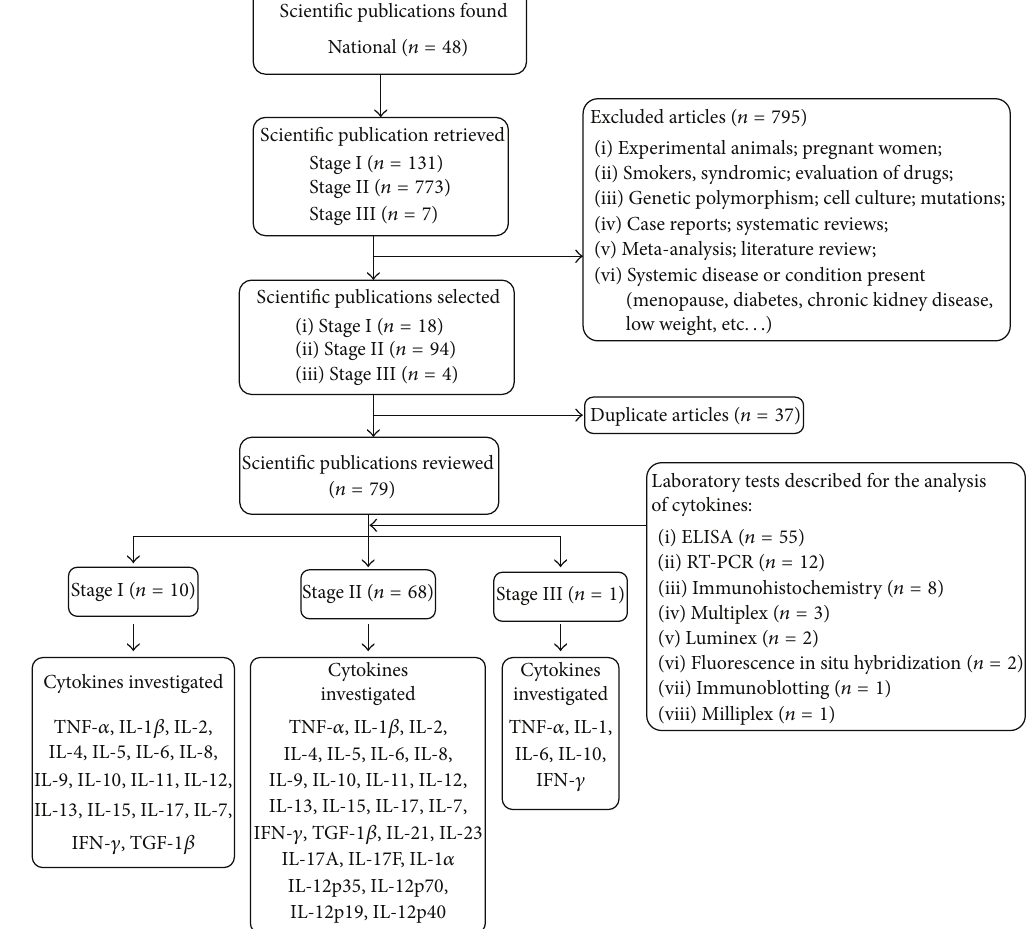
Figure 1: Flowchart of the selection of scientific articles published between January 1, 1996, and December 31, 2013, regarding inflammatory mediators involved in leprosy reactional episodes and dental infections. Stage I (bibliographic search for inflammatory mediators/leprosy reactions); Stage II (bibliographic search for inflammatory mediators/dental infections); Stage III (bibliographic search for inflammatory mediators/dental infections/leprosy